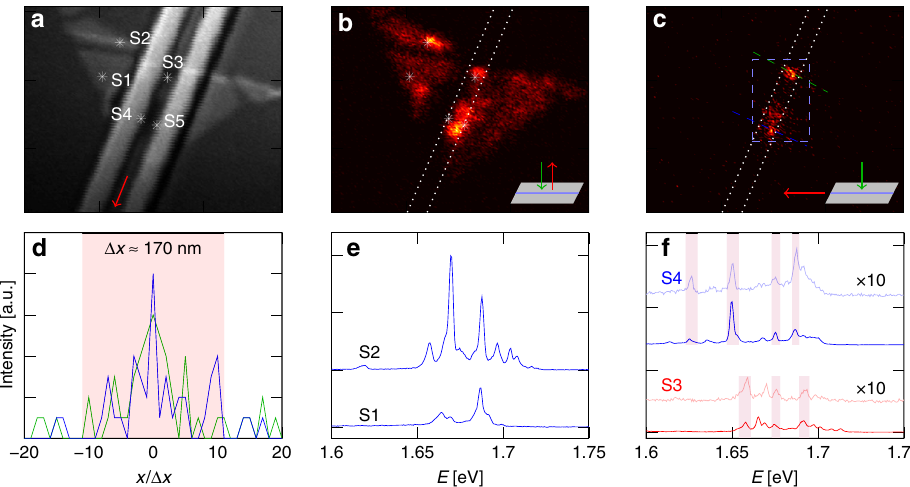
Fig. 2 Waveguide-coupled WSe 2 quantum emitters. a Confocal laser scan ( λ = 532 nm) of the relevant sample area. Spots S1 and S2 are spots off the waveguide, while spots S3 to S5 mark positions on the waveguide. The red arrow indicates the direction along which the fi ber-coupled light is collected. b Confocal PL scan, by scanning the excitation beam over the sample from the top and collecting the PL from the top. c Waveguide PL scan, by scanning the excitation beam over the sample from the top and collecting the PL through the fi ber. The white dotted lines mark the waveguide position. d Line scan along the the green and blue lines in Figure c , highlighting the estimated spatial region coupled to the waveguide (shaded red region). e PL spectra from spots S1 and S2, collected from the top. f PL spectra from spots S3 (red) and S4 (blue), collected from the top (solid color) and through the fi ber (shaded color). Matching peaks are highlighted by shaded purple regions. Where necessary, the spectrum baseline is shifted for improved visualization. The waveguide-coupled spectra are multiplied by 10. The excitation power for all PL spectra was P e ≈ 25